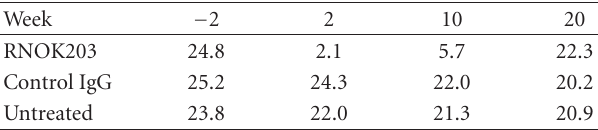
Table 1: Anti-FasL injection in vivo transiently decreases PBMC cytotoxicity. The values for specific lysis in standard conditions are shown for each specimen at time points between 2 weeks before infection ( − 2) to 20 weeks after infection. All the PBMC samples shown had mean fluorescent intensity (MFI) levels for FasL ranging from 95–180 as compared to < 90 MFI for macaques treated with anti-FasL and sampled between weeks 2 and